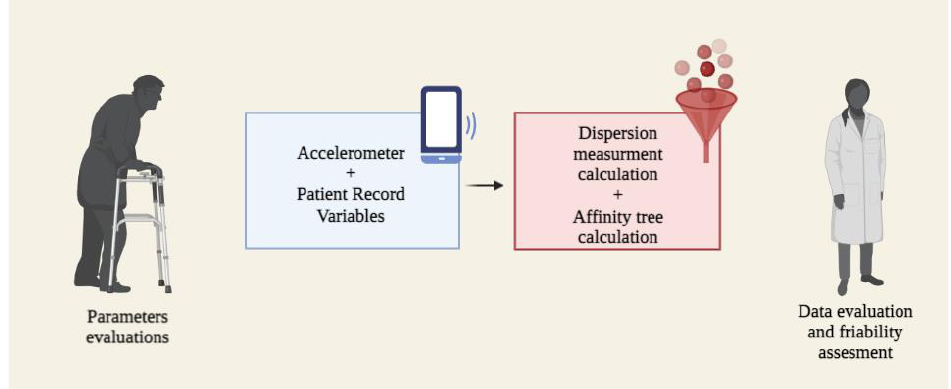
Figure 4. Activity monitoring. Embedded sensors in the SPs can detect a fall. SPs translate the information from sensors and trigger an alarm to caregivers and emergency services based on the user ’ s capability to give feedback to the SP.